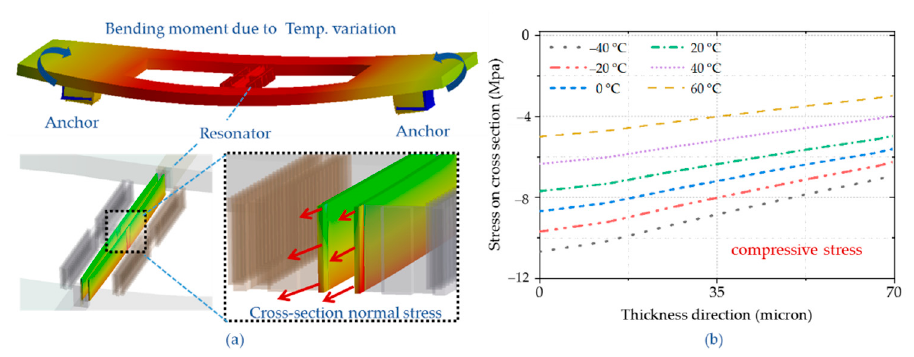
Figure 5. ( a ) Resonator model mounted by frame and the axial normal stress distributions; ( b ) The normal stress distribution along the longitudinal direction of the beam with different temperatures.